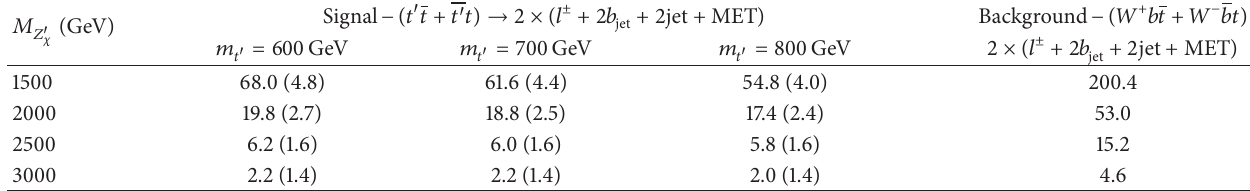
Table 13: The same as Table 12, but for 𝑍 󸀠 𝜒 .